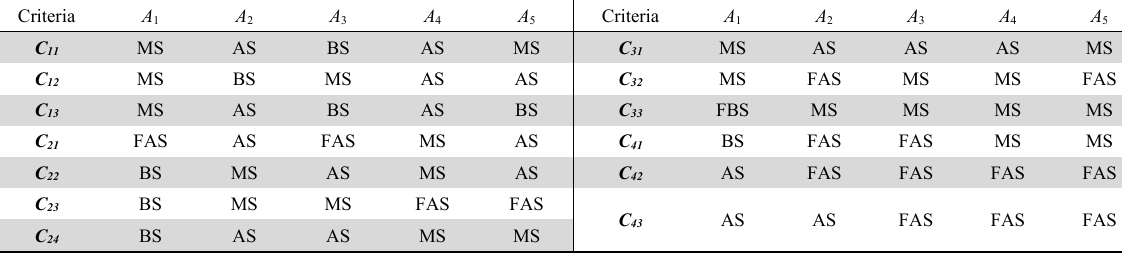
Hierarchical linguistic variables for the importance weights of criteria